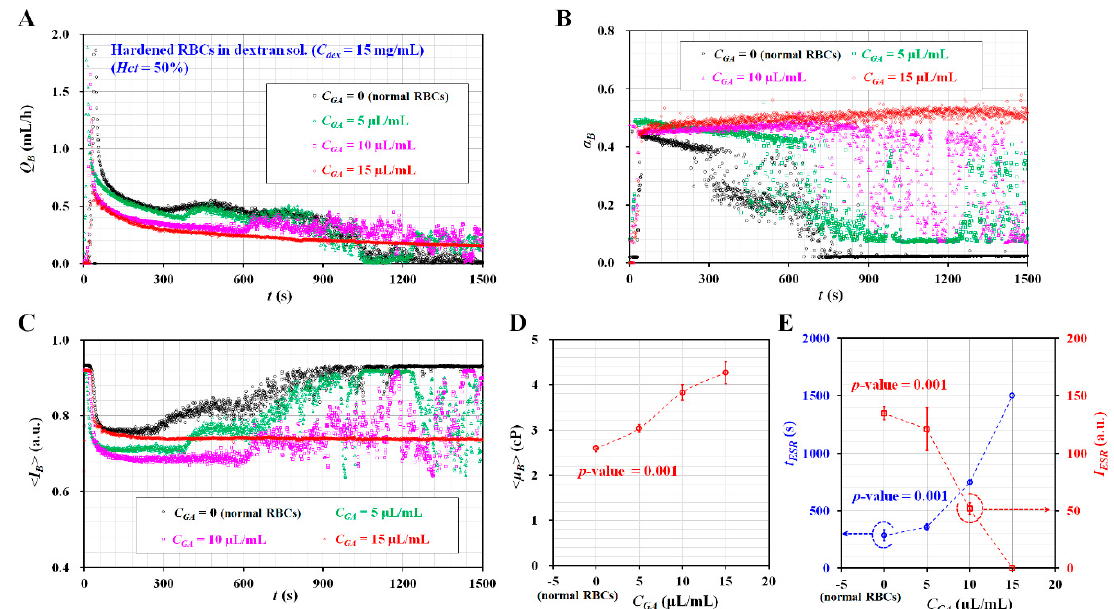
Figure 7. Measurement of blood viscosity and ESR and blood viscosity for blood samples composed of hardened RBCs with glutaraldehyde (GA) solution. To prepare hardened RBCs from normal RBCs, normal RBCs were sufficiently exposed to specific concentrations of GA solution ( C GA ) ( C GA = 0, 5, 10, and 15 μ L/mL). C GA = 0 meant normal RBCs as control. Blood sample ( Hct = 50%) was prepared by adding hardened RBCs into the dextran solution ( C dex = 15 mg/mL). ( A ) Temporal variations of Q B with respect to C GA . ( B ) Temporal variations of α B with respect to C GA . ( C ) Temporal variations of < I B > with respect to C GA . ( D ) Variations of < μ B > with respect to C GA . ( E ) Variations of two ESR indices ( t ESR , I ESR ) with respect to C GA .